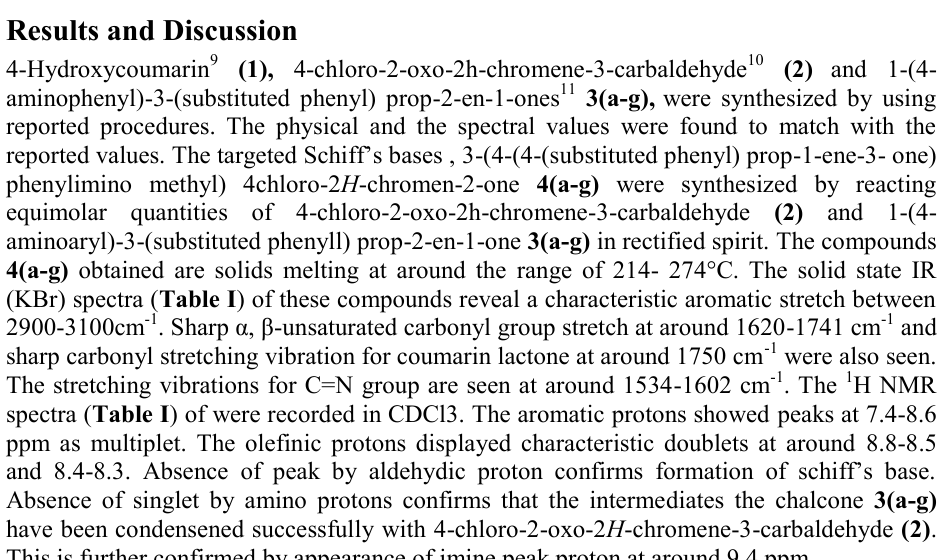
( Table III and IV ) against all the tested gram +ve and gram -ve bacteria and fungi. Compound 4b exhibited highest zone of inhibition and least MIC (20 μg/mL) against all